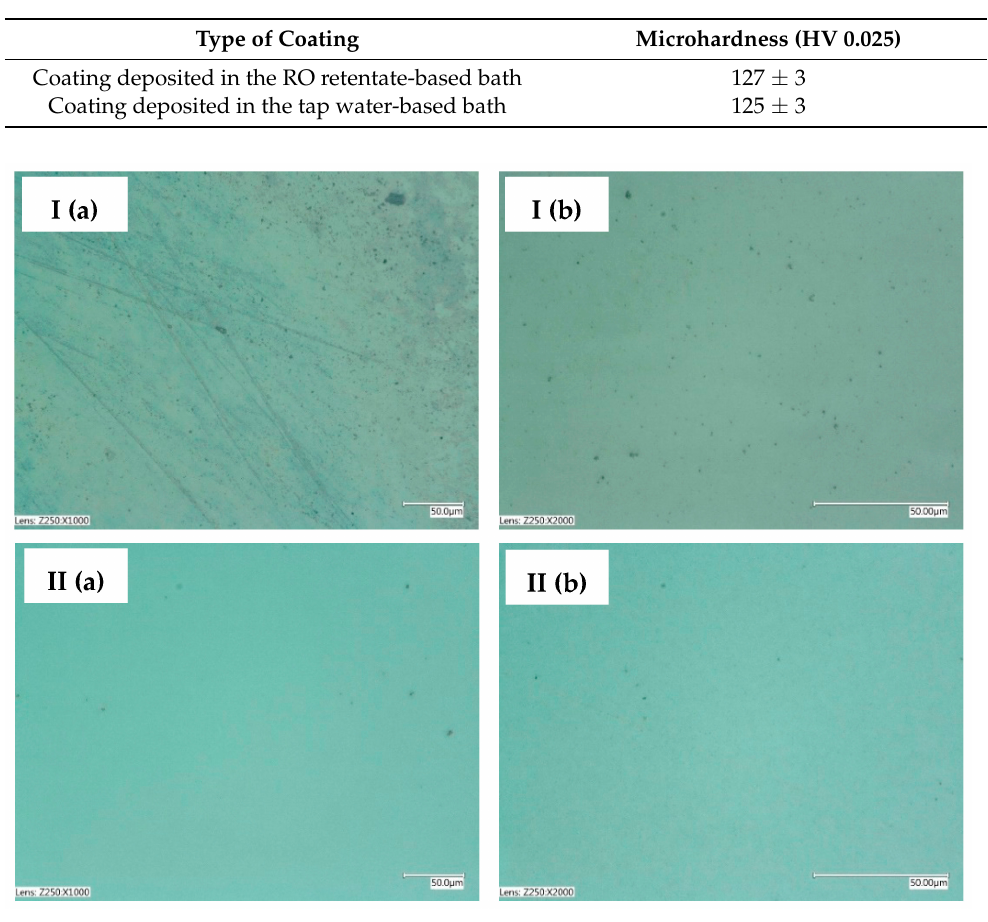
Table 5. Results of thickness measurements of zinc coatings.